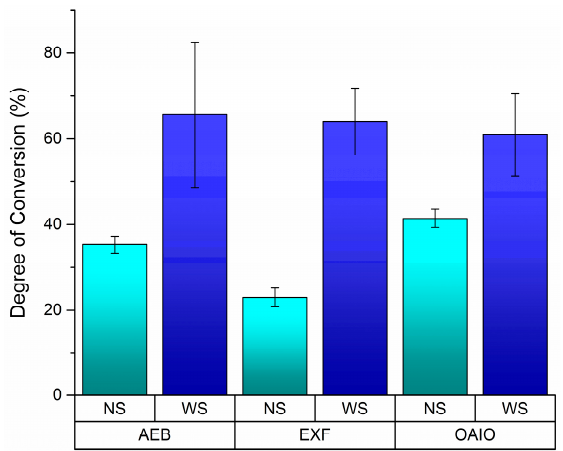
Figure 1. Degree of conversion for each brand of dental adhesive using different curing techniques. Three adhesives were used: Adper Easy Bond Self-Etch Adhesive (AEB), ExciteF Vivapen (EXF), OptiBond All-In-One (OIAO). LED and QTH are the two light curing techniques used. No strip (NS) and with strip (WS) were the two protocols to measure the effect of oxygen- inhibited layer.